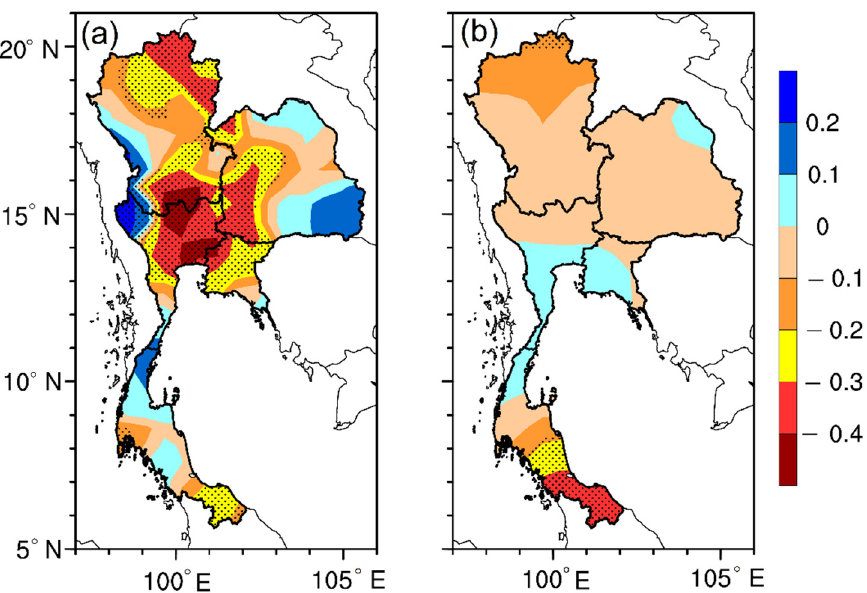
Figure 8. Temporal correlation coefficient (TCC) between ( a ) the detrended anomalies of the observed summer rainfall and sea surface temperature anomalies (SSTA) in the Niño3.4 region during the 1981–2012 period, and ( b ) the same, but for the simulated rainfall and the SSTA in the Niño3.4 region. Dotted regions indicate a significant correlation at the 90% level.